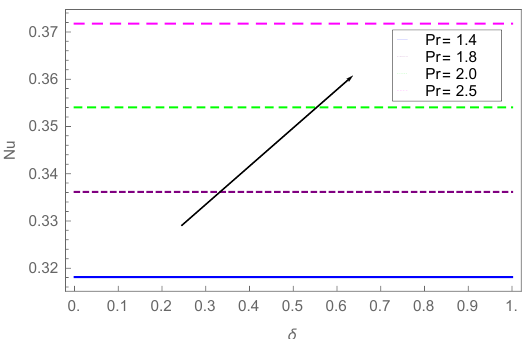
Figure 19. Plot displaying the impact of Pr on Nu .